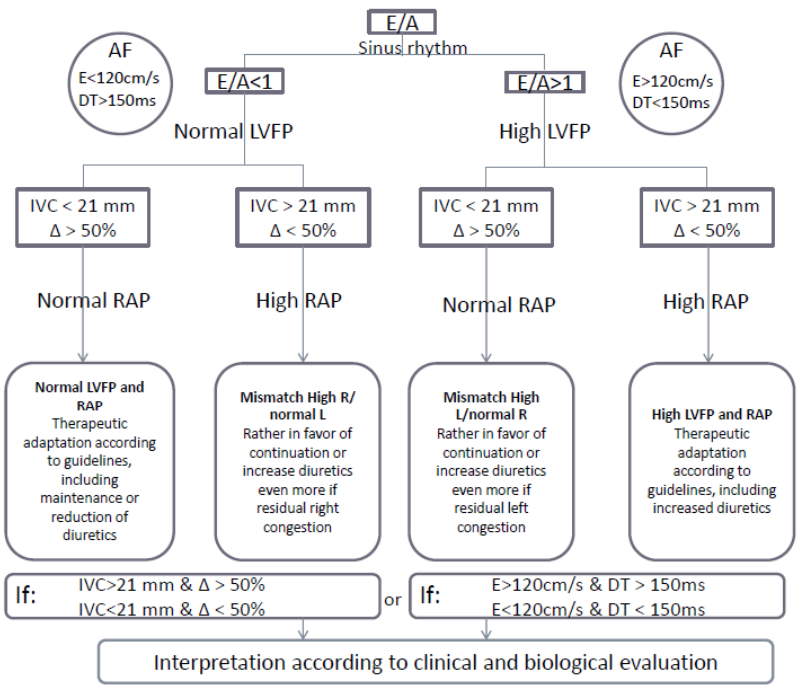
Figure A1. Therapeutic algorithm for patients included in the JetEcho group of the JECICA study. AF, atrial fibrillation; DT, deceleration time; E, peak velocity of early mitral inflow; E/A, ratio of E wave (peak velocity of early mitral inflow) and A wave (peak velocity of late mitral inflow); IVC, inferior vena cava; LVFP, left ventricular filling pressure; RAP, right atrial pressure; Δ, respiratory variation of inferior vena cava.